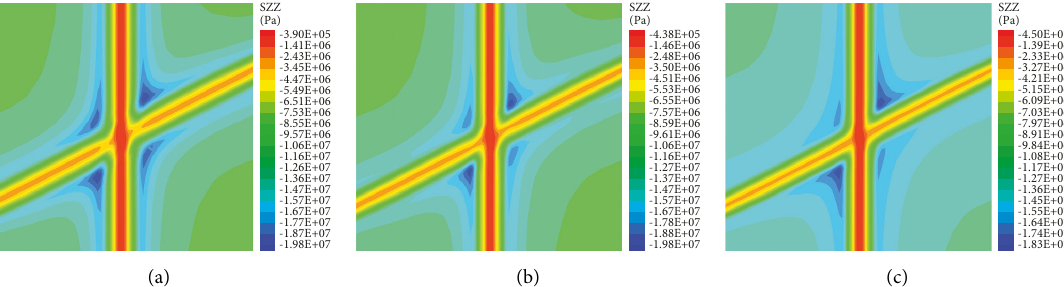
Figure 12: Disturbance influence of stress ratio on surrounding rock vertical stress of staggered roadways. (a) 0.5 ratio of horizontal stress to vertical stress, (b) 1.0 ratio of horizontal stress to vertical stress, and (c) 1.5 ratio of horizontal stress to vertical stress.